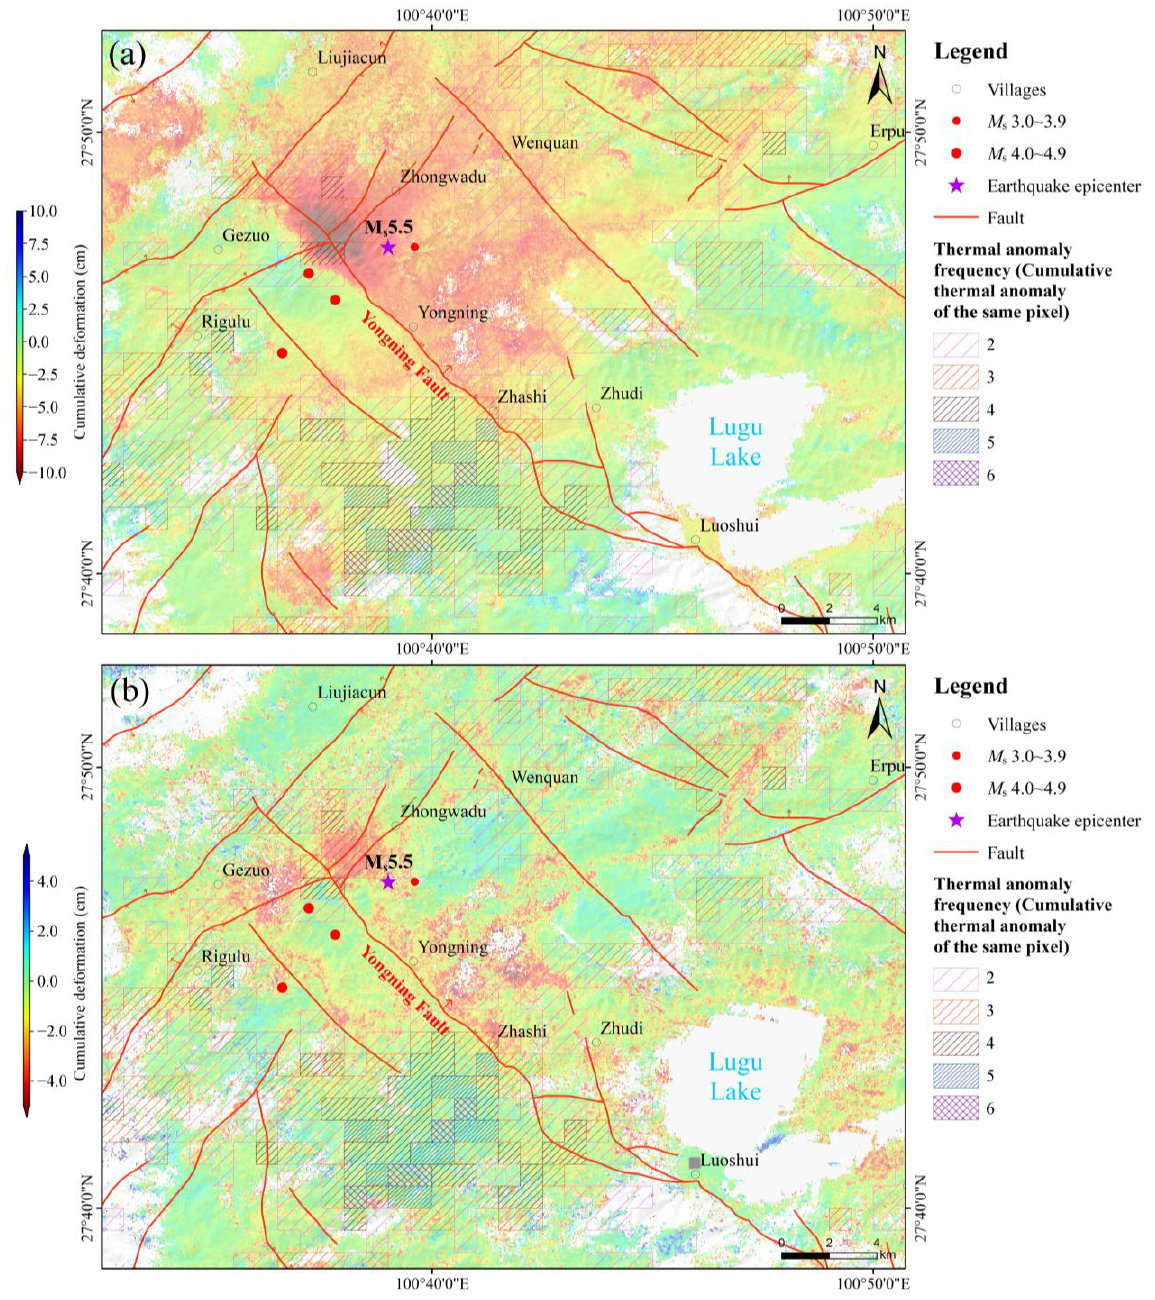
Figure 14. ( a ) The thermal anomaly frequency superimposed on the ascending orbit deformation field; ( b ) The thermal anomaly frequency superimposed on the descending orbit deformation field.